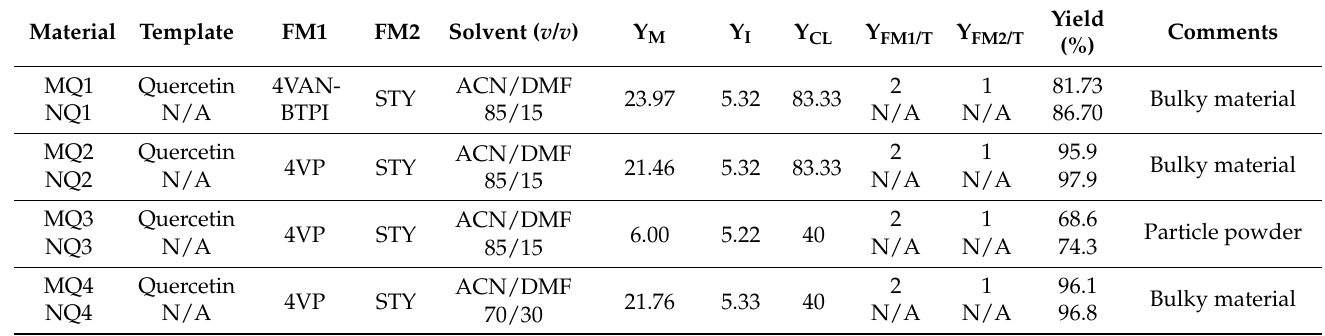
Table 1. Polymerization conditions used in the preparation of different